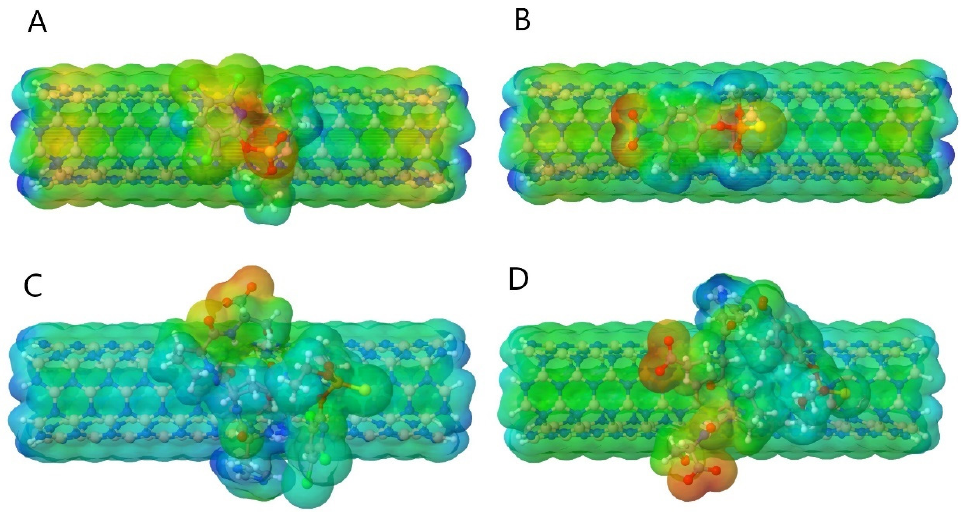
Figure 3. Electrostatic potential of pesticides (chlorpyrifos (chl) and fenitrothion (fen)) adsorbed on carbon-doped armchair (5,5) boron nitride nanotube (BN55-CC1) without ( A , B ) and decorated with tetrapeptide (4pep) ( C , D ).